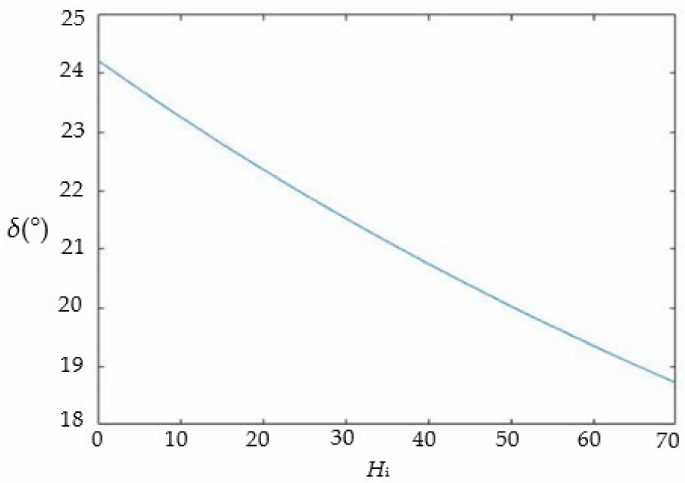
Figure 15. The variation of angle δ in different